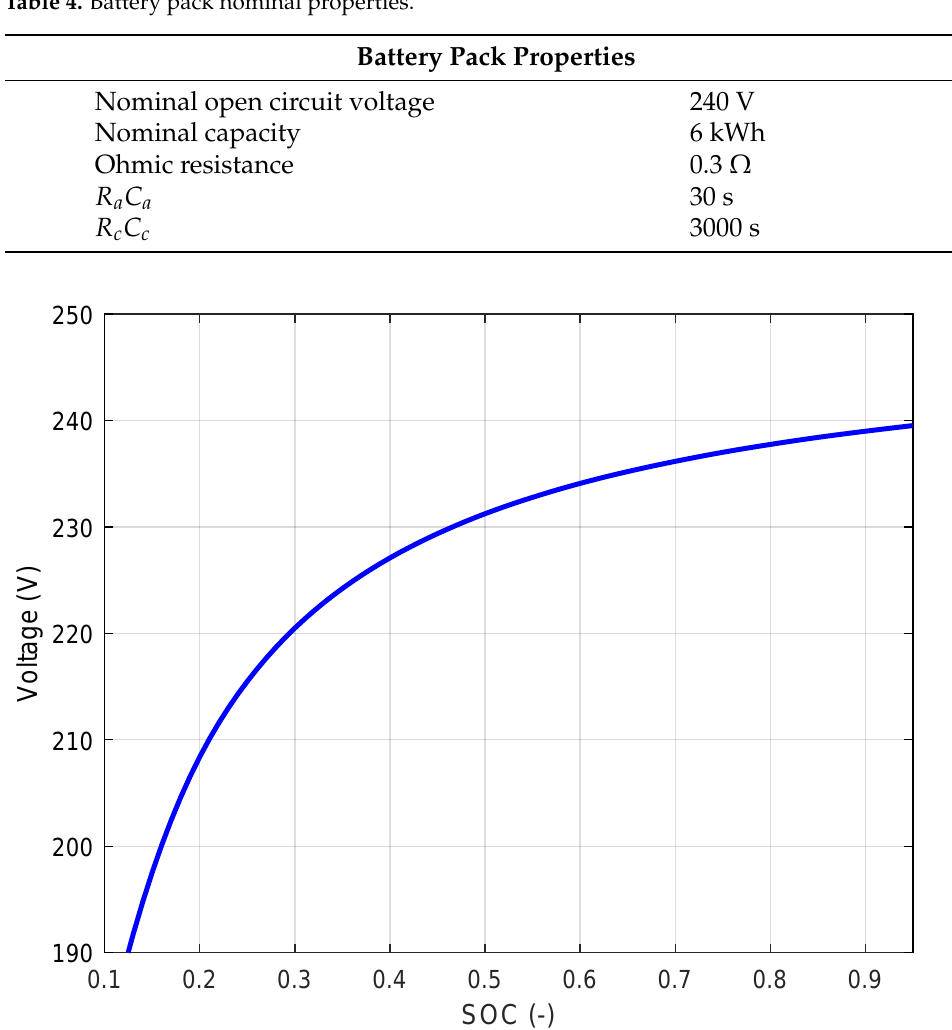
Table 4. Battery pack nominal properties.